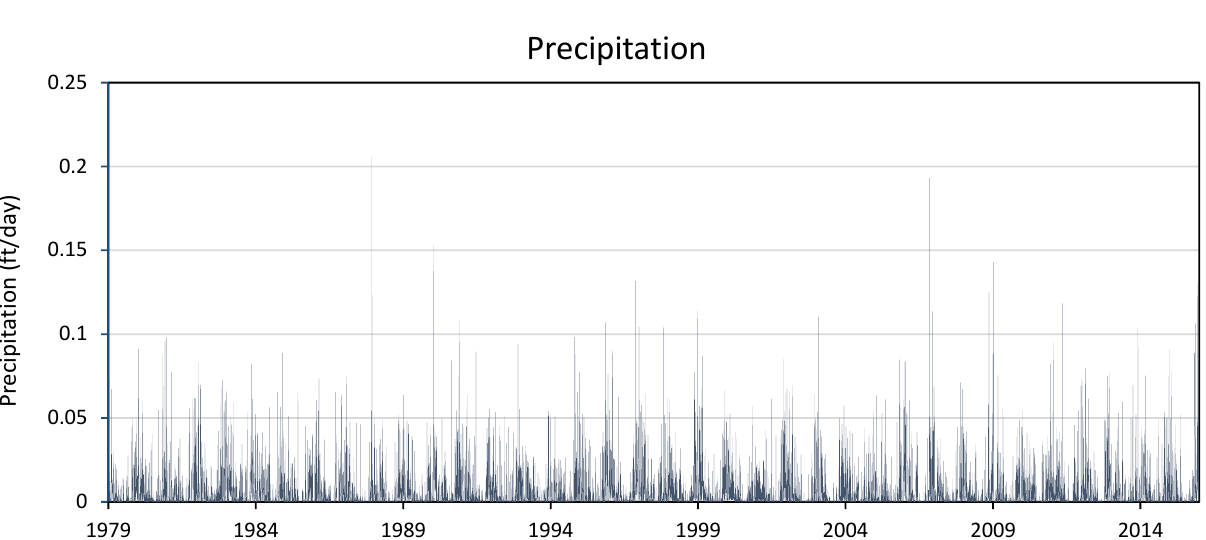
Figure A9. Input data—precipitation obtained from GridMet [73] .